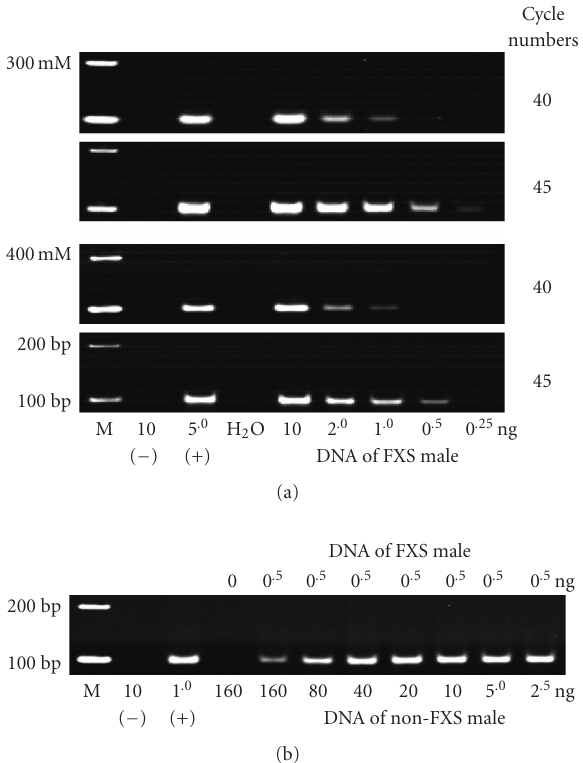
Figure 4: Detection sensitivity of MB-PCR. (a) MB-PCR analysis using di ff erent amounts of input DNA, cycle numbers of the PCR amplification, and NaCl concentration in the stringency washes. (b) MB-PCR analysis of the DNA samples simulated as mosaic FXS by mixing 0.5 ng of DNA sample from an FXS male with varying amounts of DNA sample from a non-FXS male. (–): Control DNA with universally unmethylated sequences; (+): control DNA with universally methylated sequences; (M): molecular-size